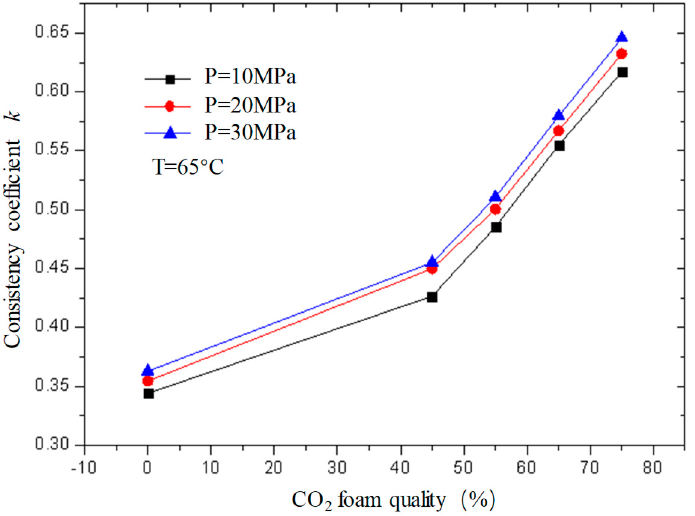
Figure 14. Variation curve of consistency index with foam quality under different pressures (foamed).